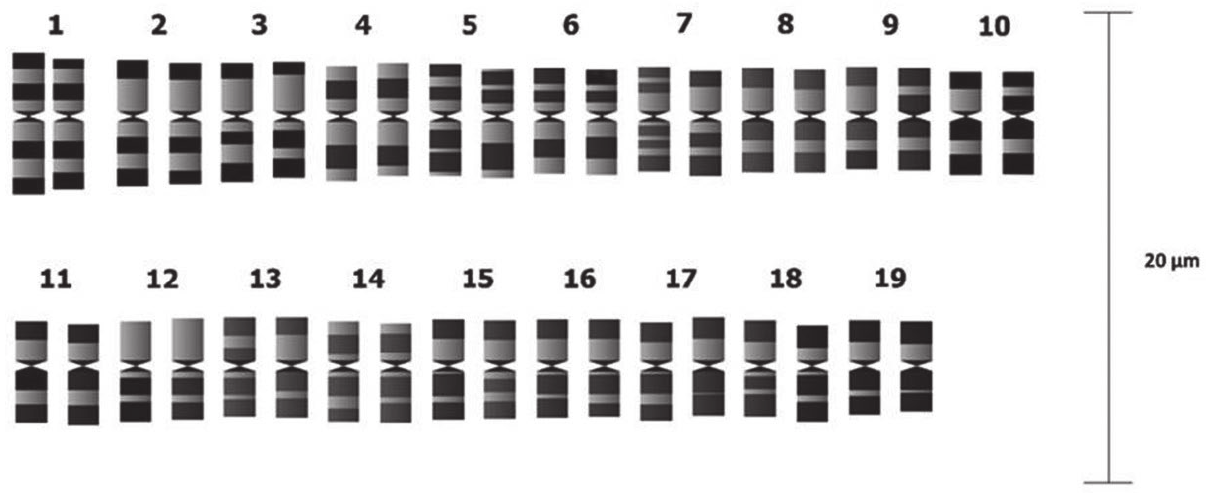
Figure 6. Ideogram of the chromosomes of Dasylirion cedrosanum Trel., with GTG